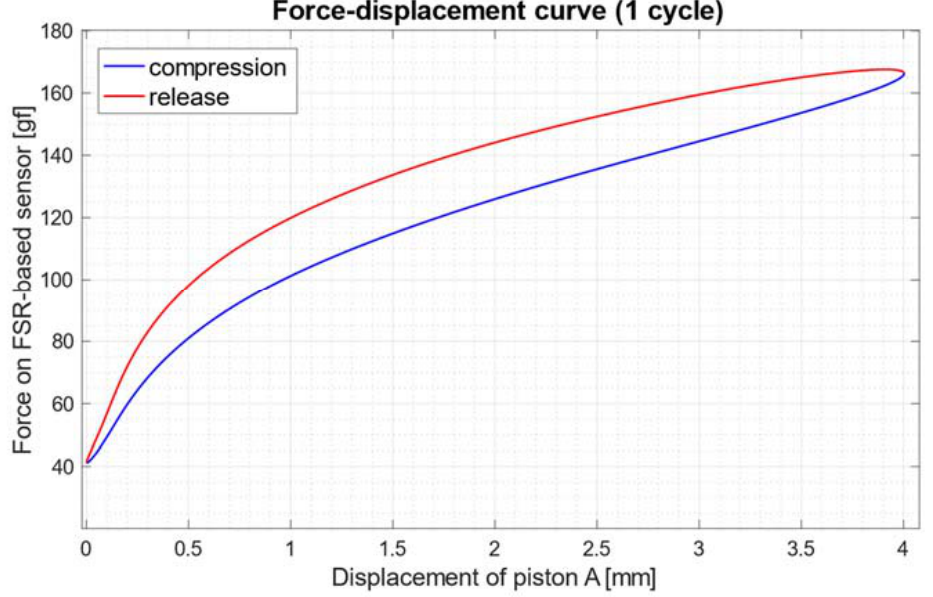
Figure 13. Relationship between the force applied on the FSR-based sensor and the displacement of piston A, for one stress cycle at 0.09 Hz. The hysteresis is graphically represented by the area between the curves depicted in red and blue.